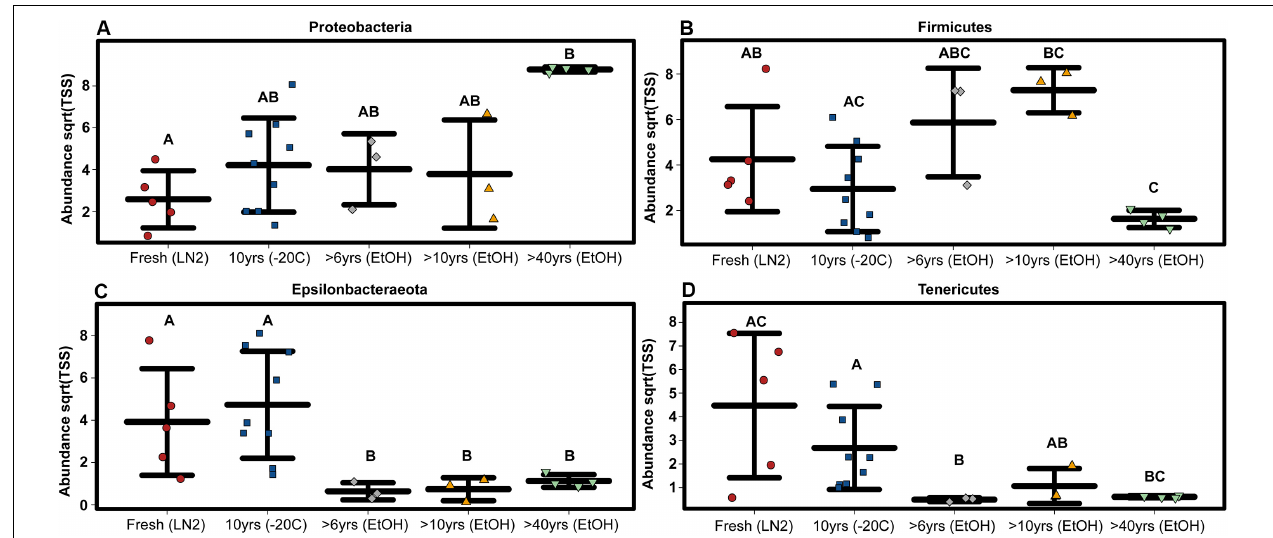
FIGURE 3 | Alpha diversity strip charts constructed based on OTUs showing (A) bacterial OTU level Shannon diversity for sample age, (B) bacterial OTU level Shannon diversity for sample preservation type, (C) bacterial phyla level Shannon diversity for sample age, and (D) bacterial phyla level Shannon diversity for sample preservation type. Significant differences based on non-parametric Kruskal-Wallis tests ( P < 0.05) are indicated by letters above the strips.